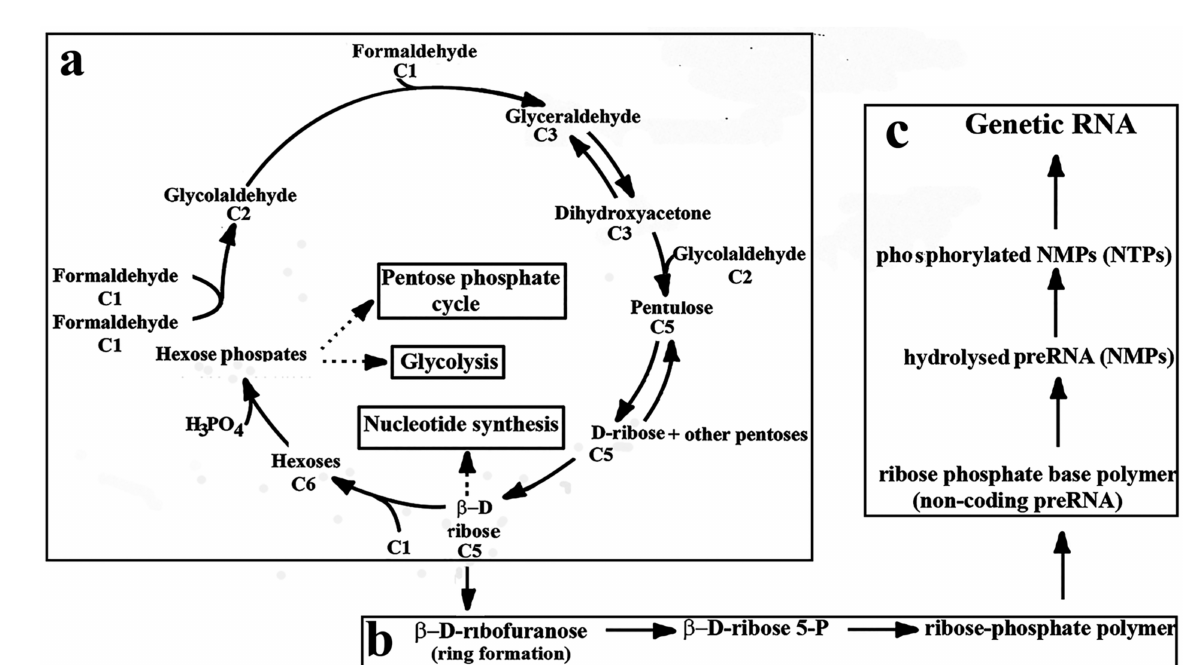
Figure 4. Theoretical f ormose–ribose–RNA pathway. The pathway consists of three parts. ( a ): Formose reaction: Two formaldehyde (C1) forms glycolaldehyde (C2). Formaldehyde (C1) and glycolaldehyde (C2) react to give glyceraldehyde (C3). Glyceraldehyde isomerizes reversibly to dihydroxyacetone (C3). The addition of glycolaldehyde (C2) to dihydroxyace- tone (C3) generates pentulose (C5) that isomerizes to D -ribose and other pentoses (C5). Insets: The formose reaction is the generator of abiotic metabolism and thought to initiate other pathways such as pentose-phosphate pathway, glycolysis, nucleotide biosynthesis, ( b ): Polymerization of β - D -ribose preceded by ring formation to D -ribose, the phosphorylation of β - D -ribose, and polymerization of β - D -ribose-5P to form the ribose-phosphate backbone. ( c ): Attachment of nucleobases to the ribose-phosphate backbone to bring about preRNA, hydrolysis of preRNA to the smallest nucleotide units (NMPs), the phosphorylation of which leads to NTPs, the substrates of genRNA. Double arrows show the reversibility of the reactions. Dotted arrows refer to processes developed later during the